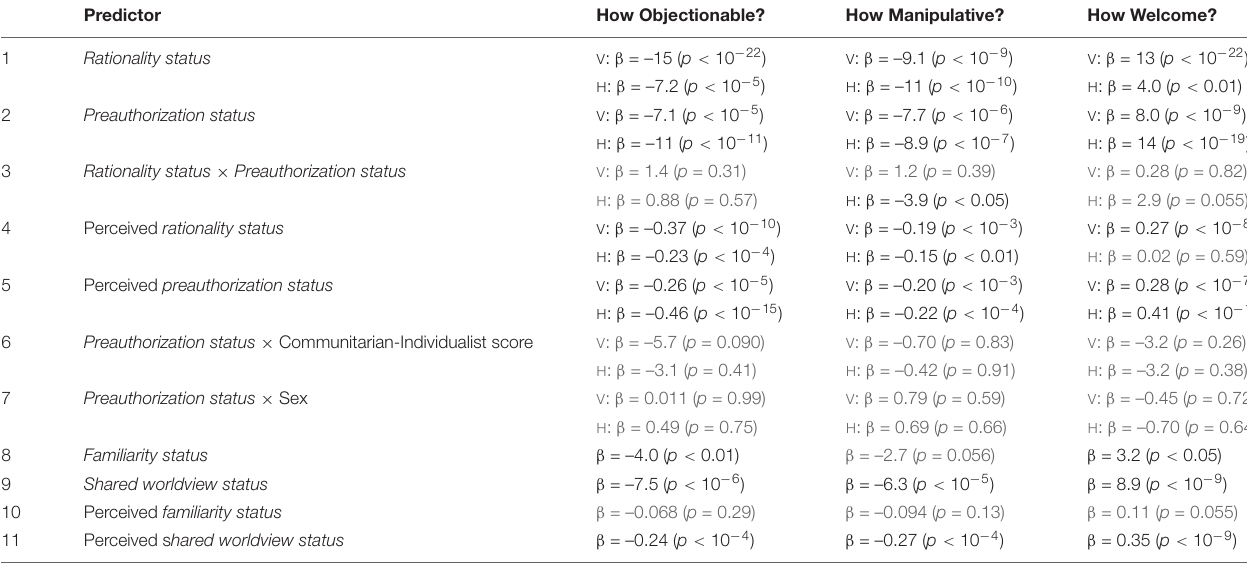
TABLE 2 | Logistic regression